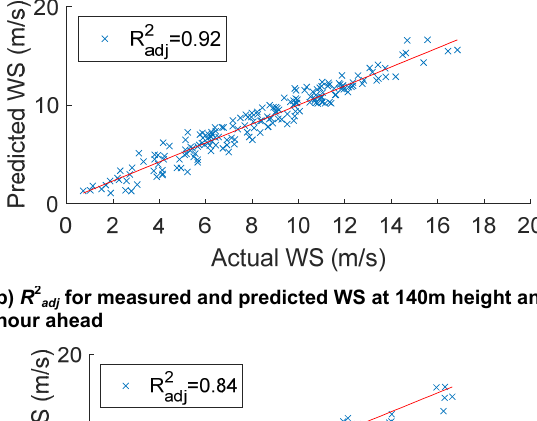
Figure 3. Performance at height 100m